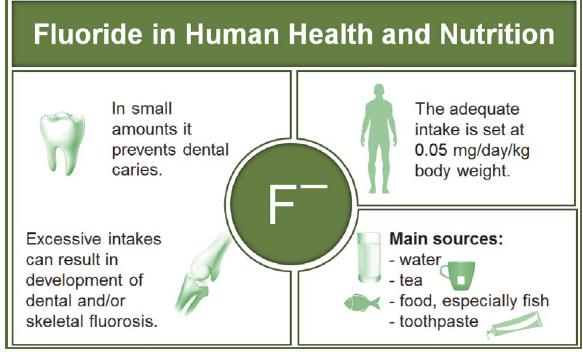
Figure 1: The adequate intake of fluoride in relation to its beneficial/ adverse effects and the main sources of fluoride for